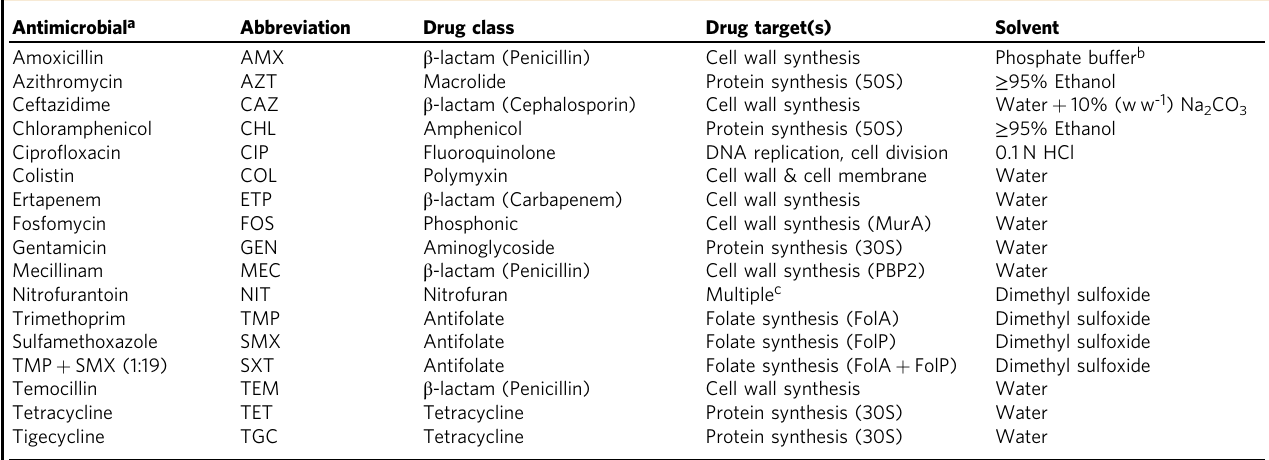
Table 2 List of antimicrobials used in this study Antimicrobial